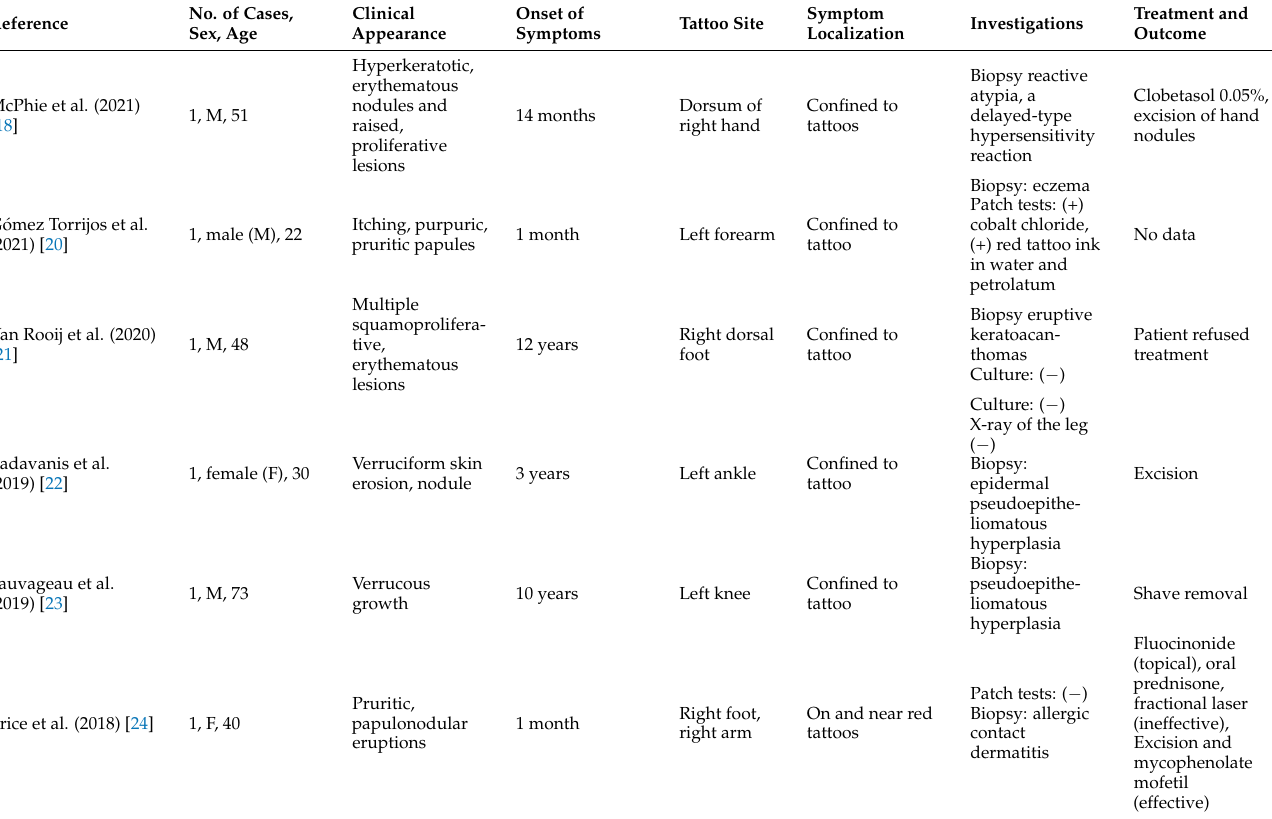
Table 1. Review of clinical cases concerning red ink tattoo complications from the last